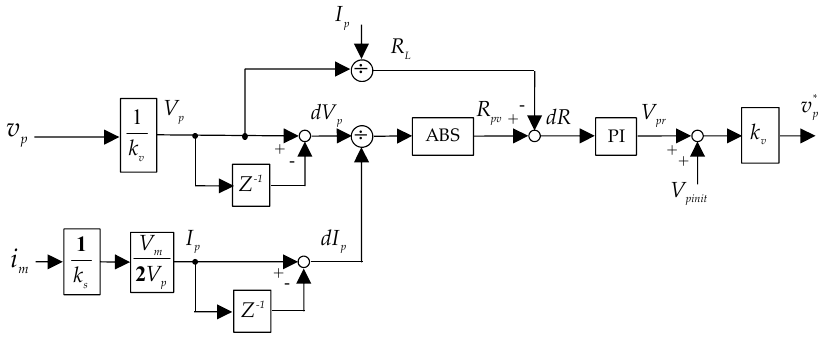
Figure 9. Improved INC MPPT controller without sensing the input